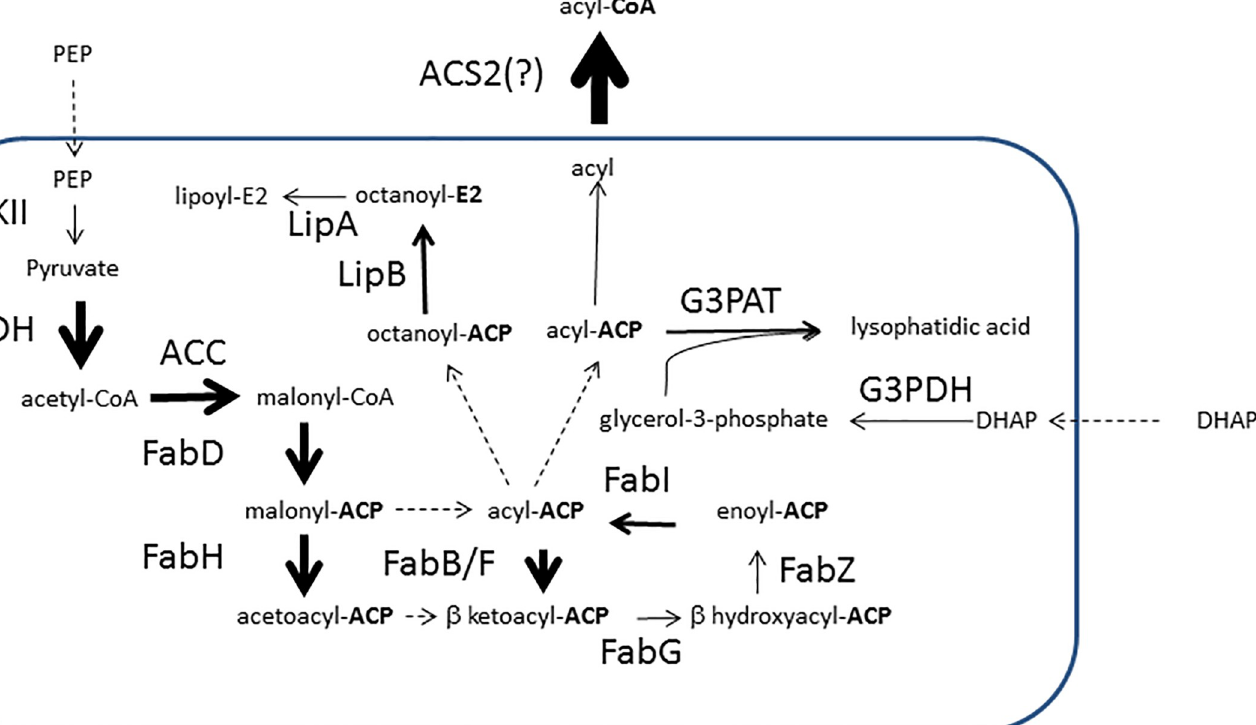
PLOS Computational Biology | https://doi.org/10.1371/journal.pcbi.1008067 April 30,